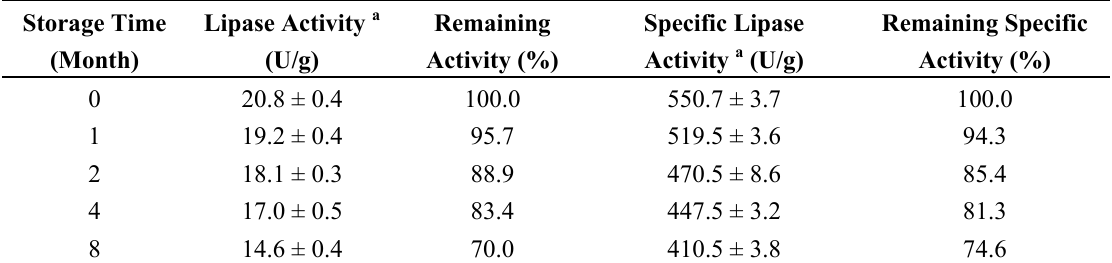
Table 2. Effect of storage at 4 °C on the activity of mycelium-bound